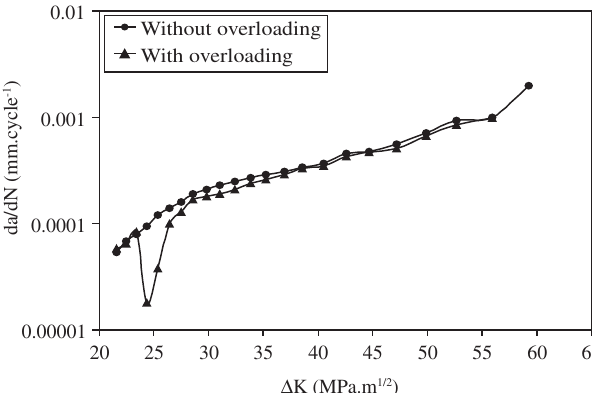
Without overloading With overloading